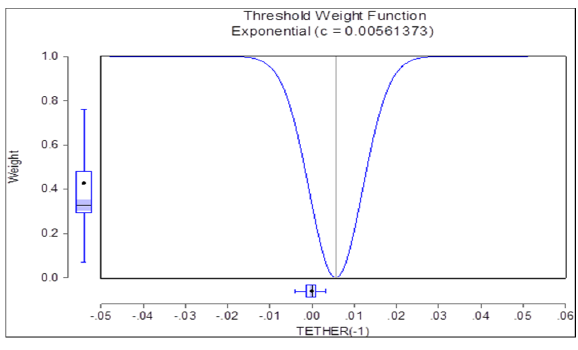
Figure 2. Shape of threshold weights. Table 5. Smooth transition autoregressive (STAR) model estimates.